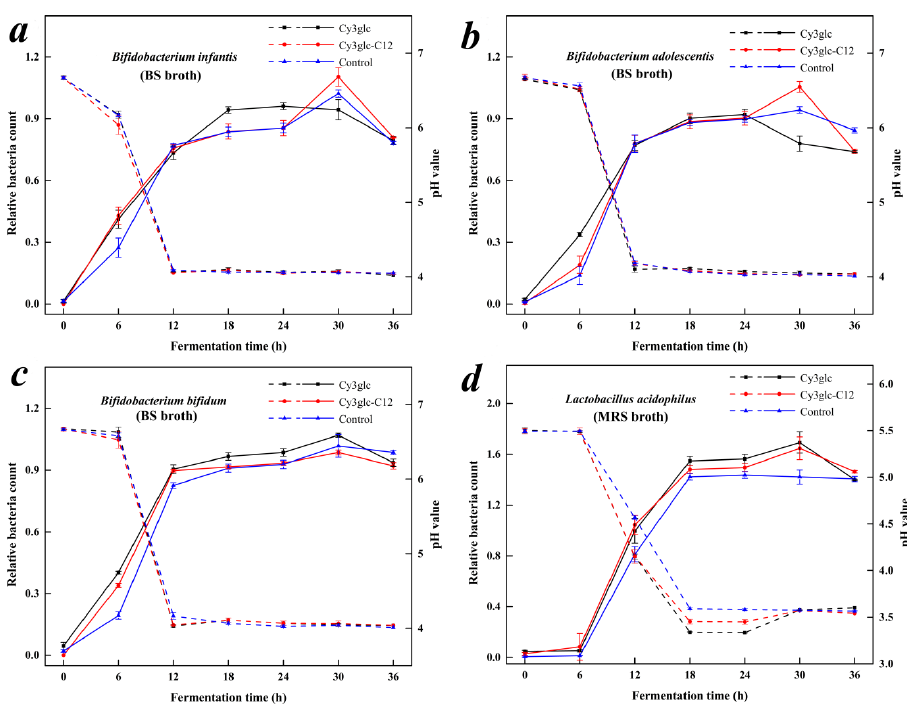
Figure 5. The change of strains growth (solid line) and pH value (dotted line) during the fermentation with Cy3glc or Cy3glc-C12. BS, and MRS broth without anthocyanins were kept as the control groups (CG). Error bars represent the standard deviations of the mean of three replicates (n = 3). ( a ) B. infantis growth in BS broth; ( b ) B. adolescentis growth in BS broth; ( c ) B. bifidum growth in BS broth; ( d ), L. acidophilus growth in MRS